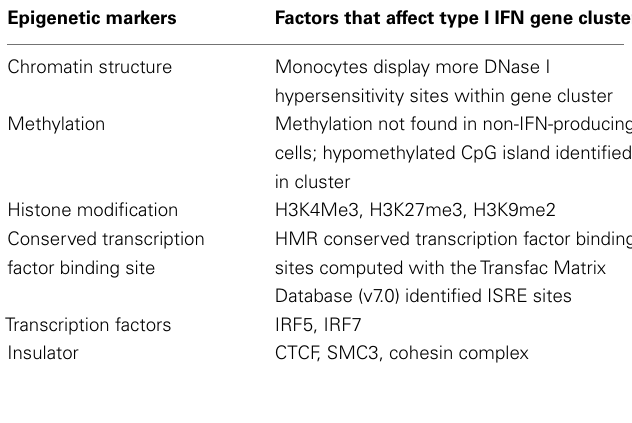
Table 2 | Results from the computational analysis of ENCODE next-generation sequencing data on the type I IFN gene